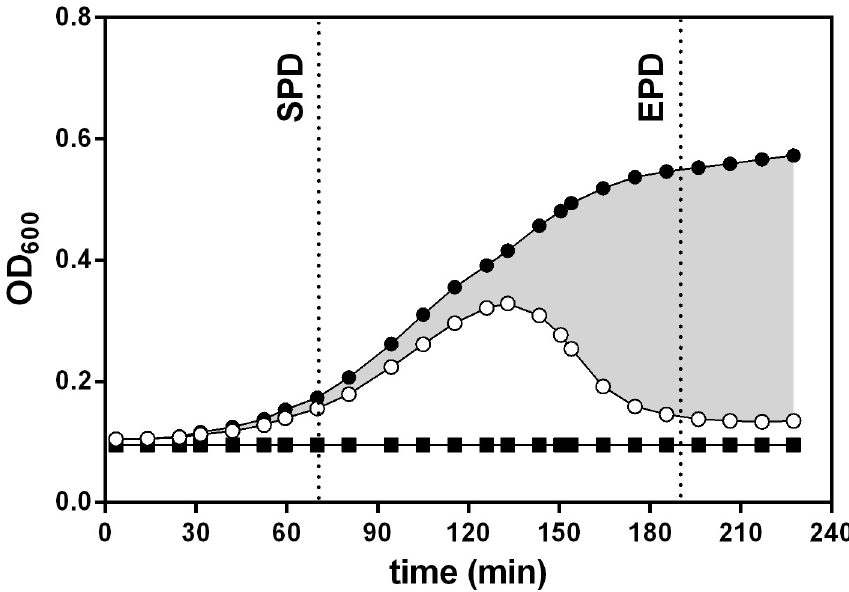
Fig 1. Graphical representation of the procedure used to determine inhibition due to phage lysis in each experiment. Optical density vs time curves of a control ( ● ) and a phage-inoculated culture ( � ) were integrated and subtracted. The difference, represented by the shaded area, indicates the extent of the inhibition. This area is expressed as a percentage of the area of the control. In cases with little or no phage effect, the shaded area is very small and the percentage of inhibition approaches 0%. In the most extreme cases the shaded area virtually coincides with the area of the control, and the percentage of inhibition approaches 100%. In order to standardize all calculations, integration is carried out between the Start Point of Detection (SPD) and End Point of Detection (EPD) as defined in the text.